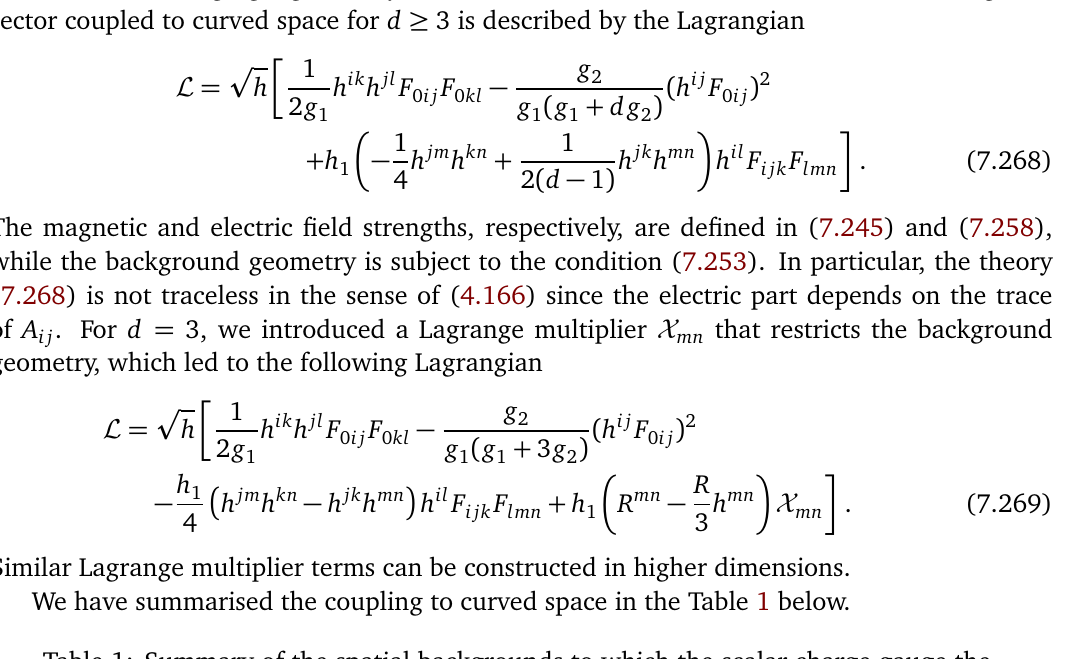
Table 1: Summary of the spatial backgrounds to which the scalar charge gauge the- ories can couple in a gauge-invariant way. The electric theory is given in (7.257) if it is traceful and in (7.265) if it is traceless. The magnetic theory is given in (7.249). Recall that the scalar charge gauge theory, for which h trivial magnetic sector for d ≥ 3 (c.f., (4.164)). The condition for constant sectional curvature is given in